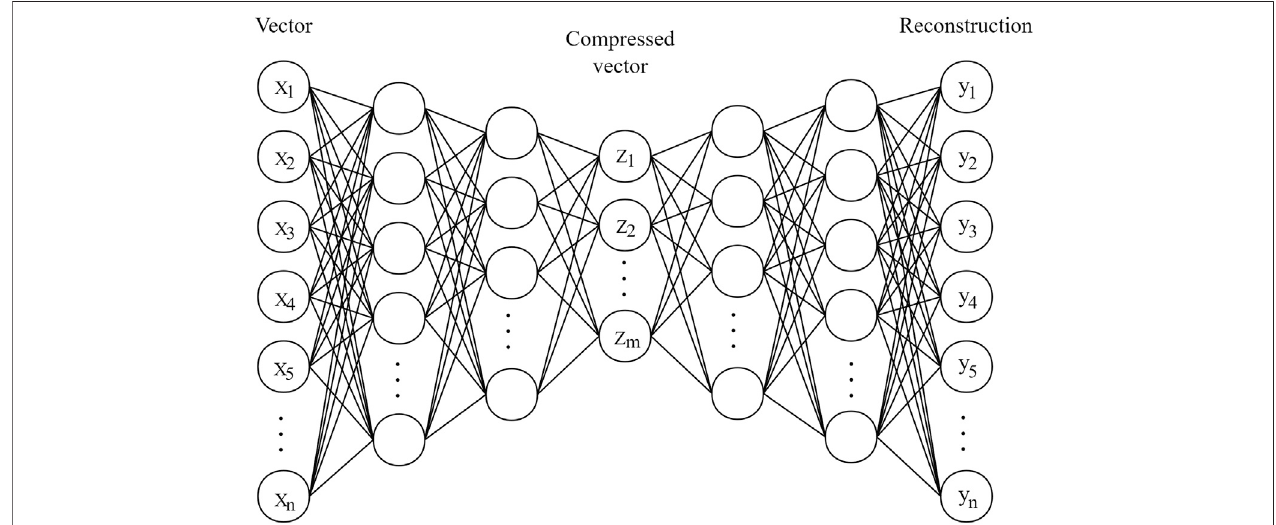
FIGURE 3 | Deep autoencoder model.